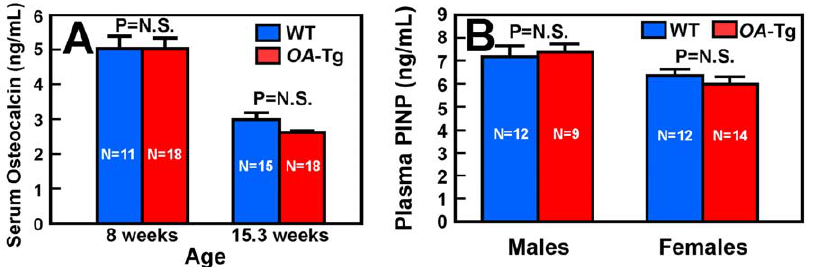
Figure 10. Effects of targeted overexpression of OA in osteoclastic cells on plasma levels of biomarkers of bone formation invivo . In A, plasma levels of osteocalcin of female OA -Tg mice and WT littermates of 8 or 15.3 weeks of age were measured with a commercial ELISA kit. Results are shown as mean 6 SEM with the indicated the number of mice per group. In B, plasma levels of pro-collagen type I N-terminal peptide (PINP) of both male and female 15.3-week-old OA -Tg mice and corresponding age- and sex-matched WT littermates were measured with a commercial ELISA kit. Results are shown as mean 6 SEM with the indicated number of mice per group. doi:10.1371/journal.pone.0035280.g010 PLoS ONE |